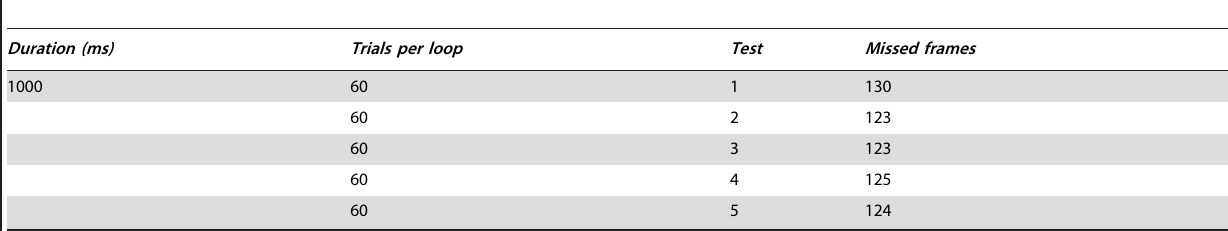
Table 2. PsychoPy 1.80 timing tests on MacBook Pro Late 2013 under Windows 7 64-bit Ultimate.